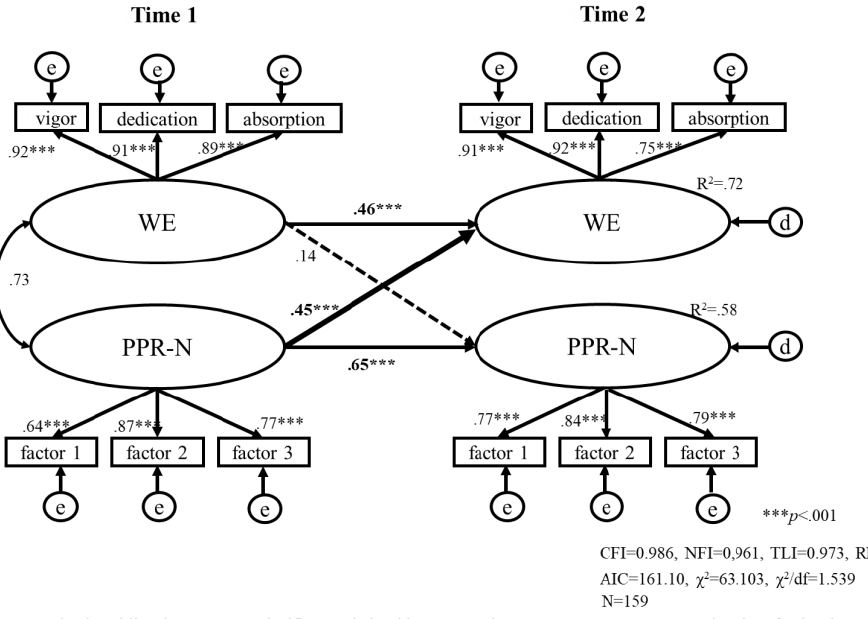
Figure 4: CFI = 0.986, NFI = 0.967, RMSEA = 0.055).